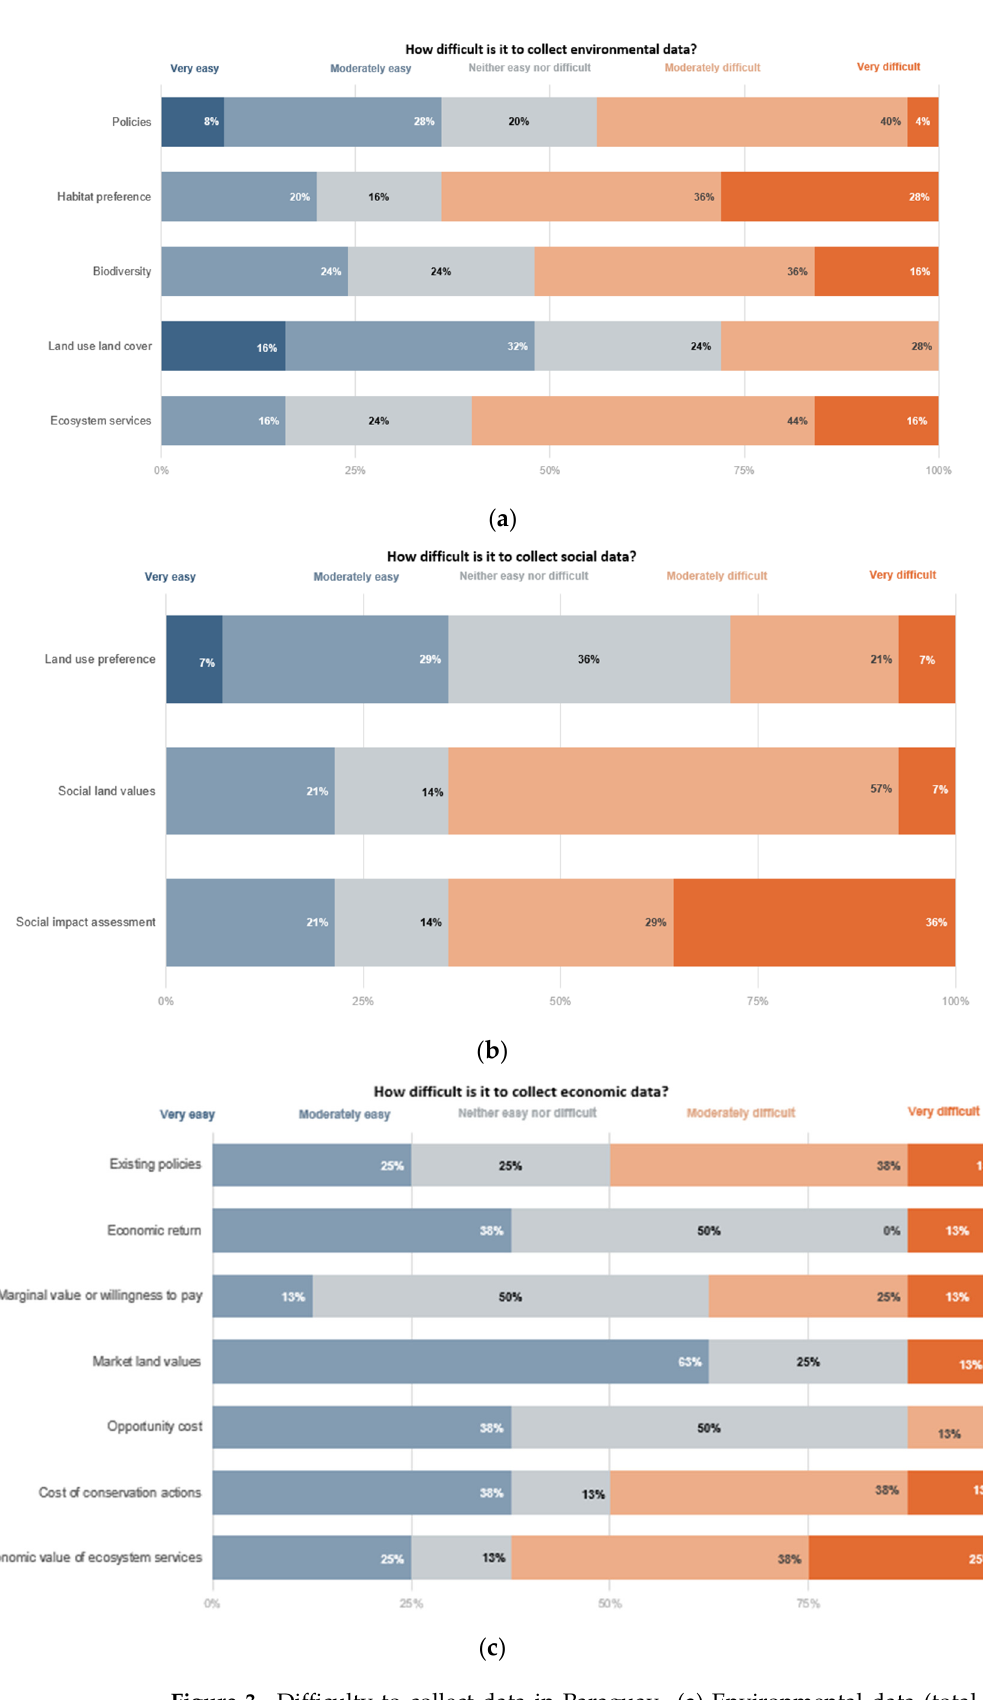
Figure 3. Difficulty to collect data in Paraguay. ( a ) Environmental data (total of 25 responses). ( b ) Social data (total of 14 responses). ( c ) Economic data (total of 8 responses).